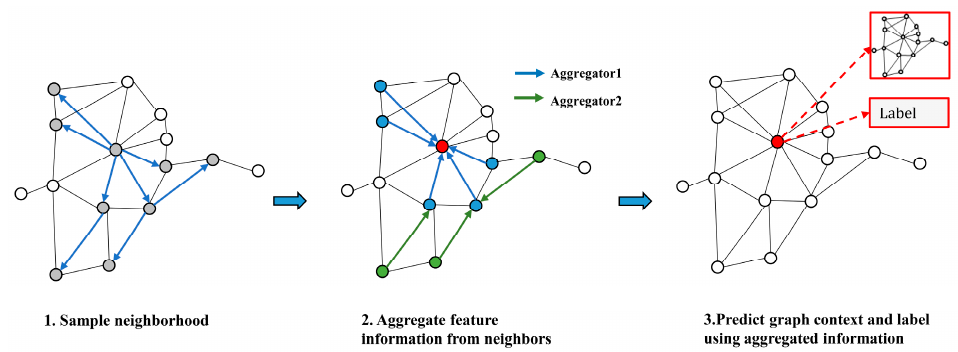
Figure 7. Graph SAGE aggregation process.